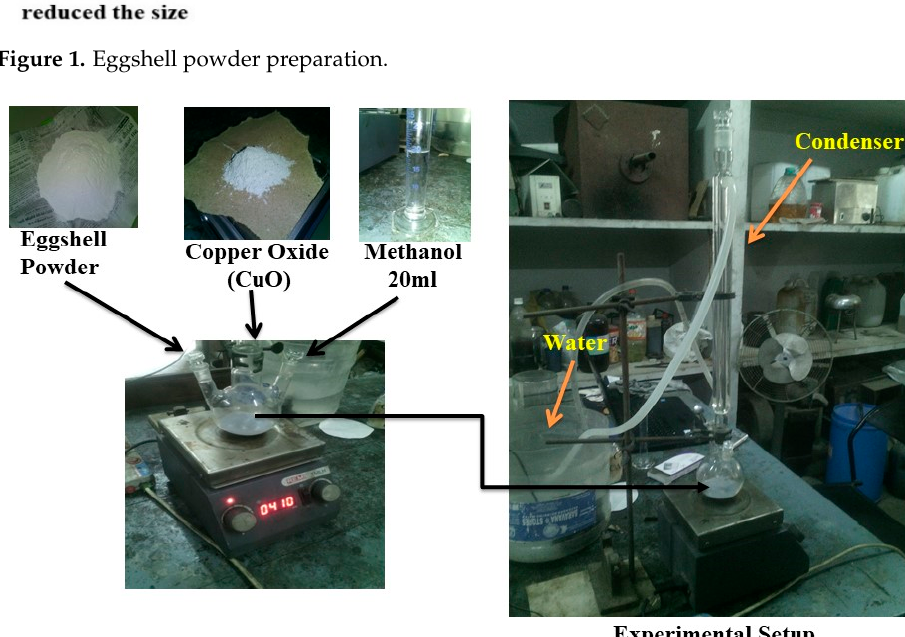
Figure 2. Preparation of calcium-copper oxide catalyst.